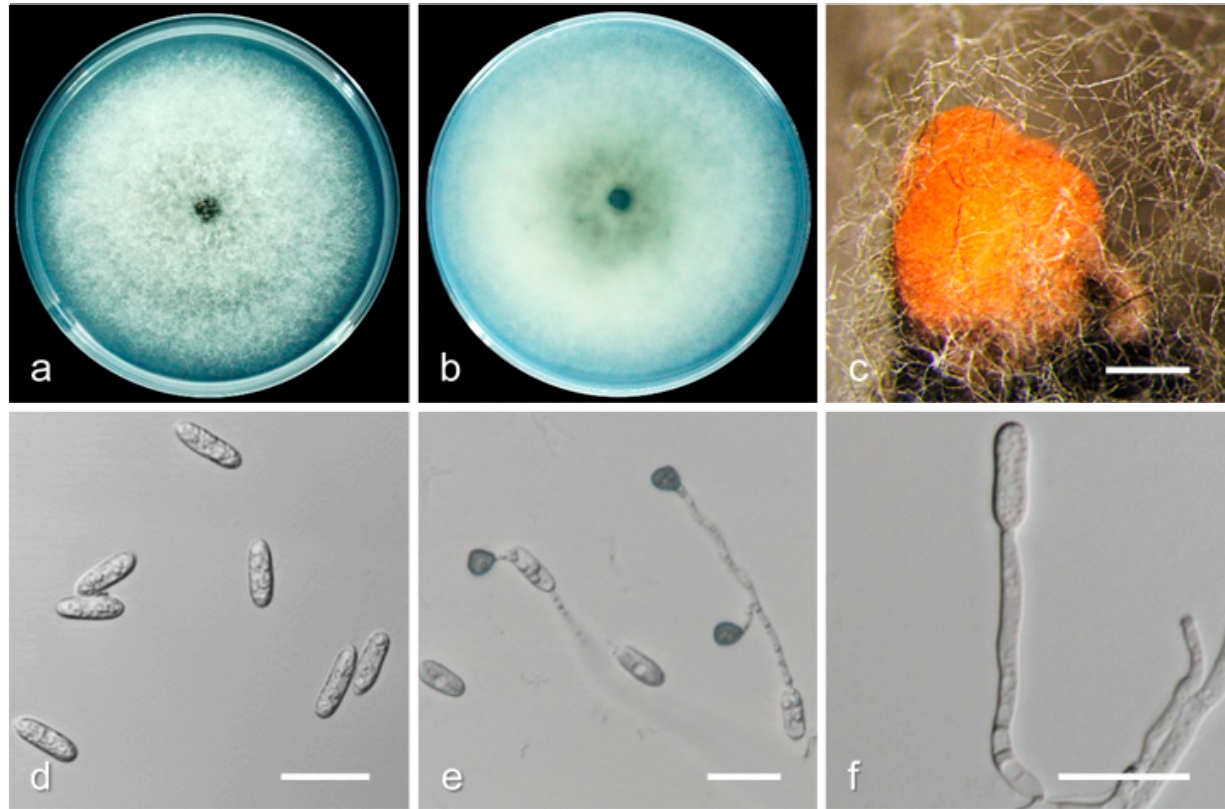
Figure 12. Biological characteristics of Colletotrichum siamense . ( a , b ) Front and back view of six-day-old PDA culture; ( c ) conidiomata; ( d ) conidia; ( e ) appressoria; ( f ) conidiophores (( a – e ) isolate SDQD10-1; ( f ) isolate HBSJZ 1-1). Scale bars: ( c ) = 200 µ m; ( d – f ) = 20 µ m. Description and illustration—Prihastuti et al.